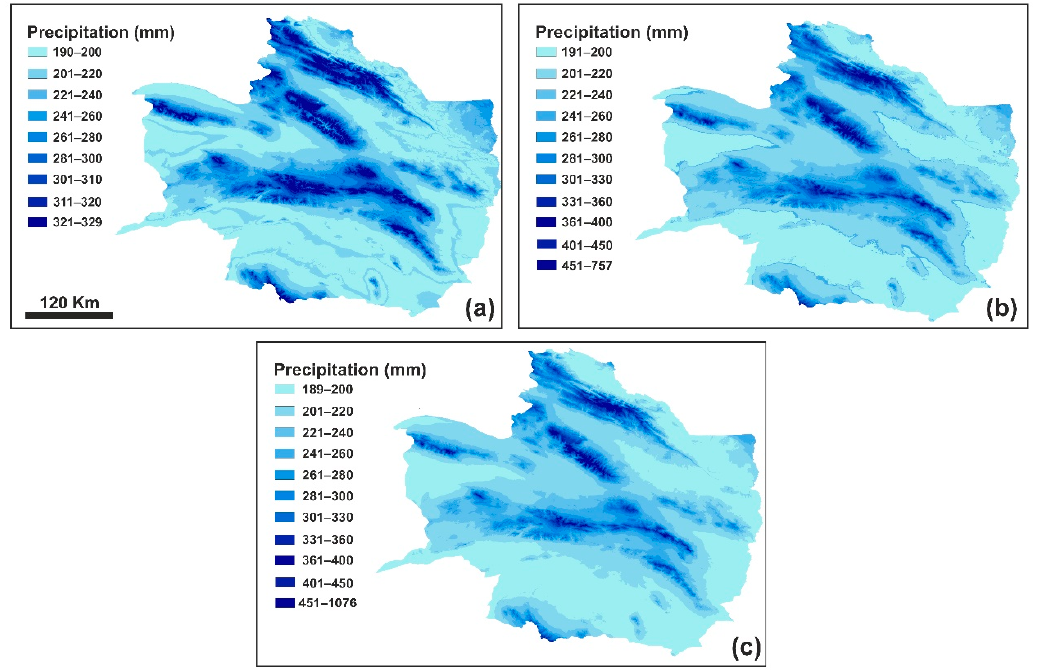
Figure 7. Interpolated annual precipitation maps obtained by applying the three non-linear regression methods: ( a ) Sinosoidal, ( b ) Hoerl, ( c ) Steinhart-Hart Equation. Please note that the individual maps have different precipitation scales.